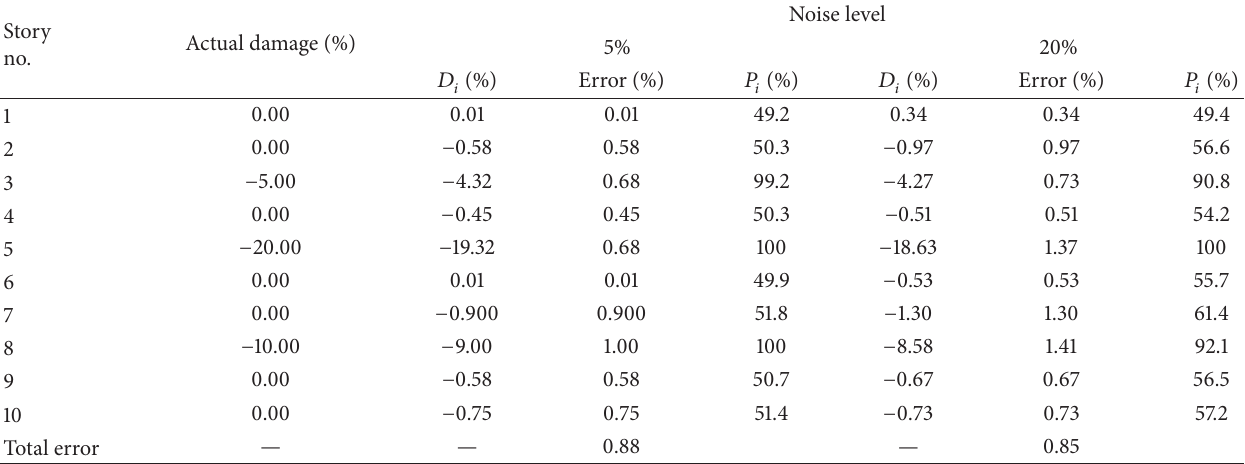
Table 1: Comparisons of identified damage indices and damage